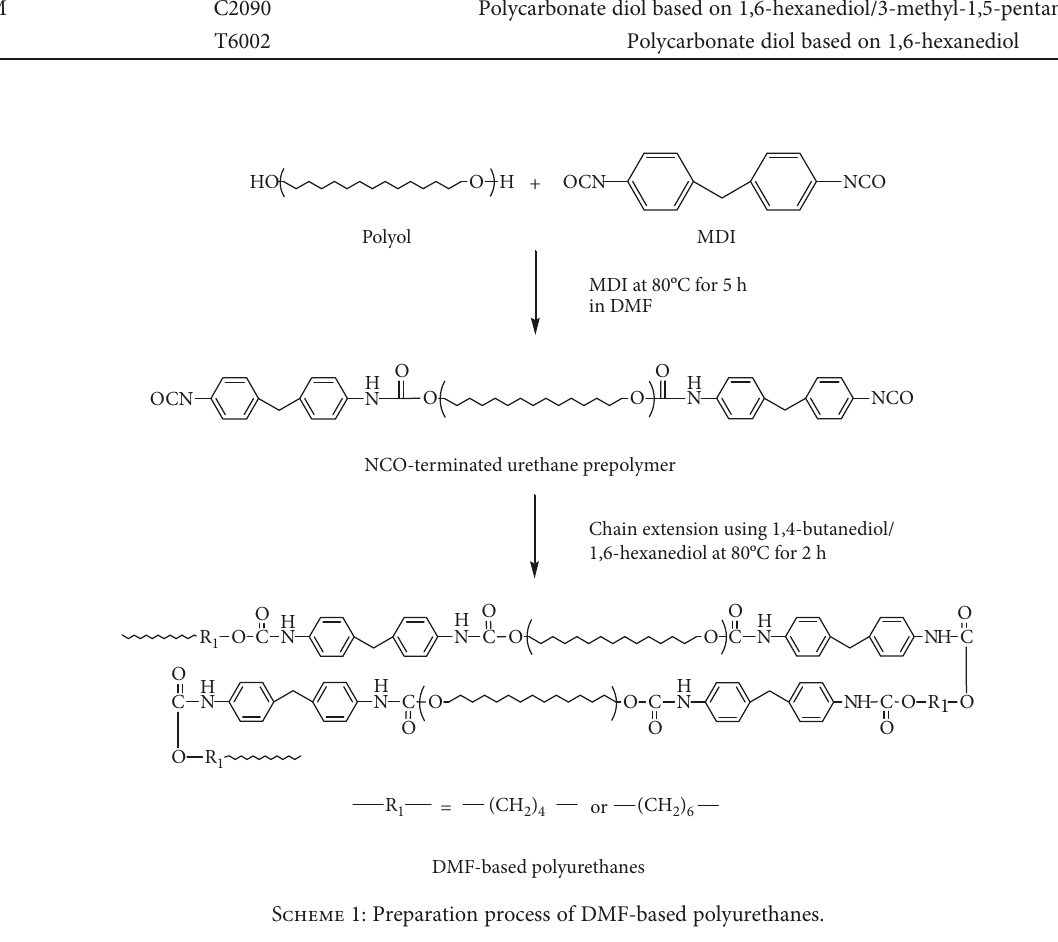
Scheme 1: Preparation process of DMF-based polyurethanes.